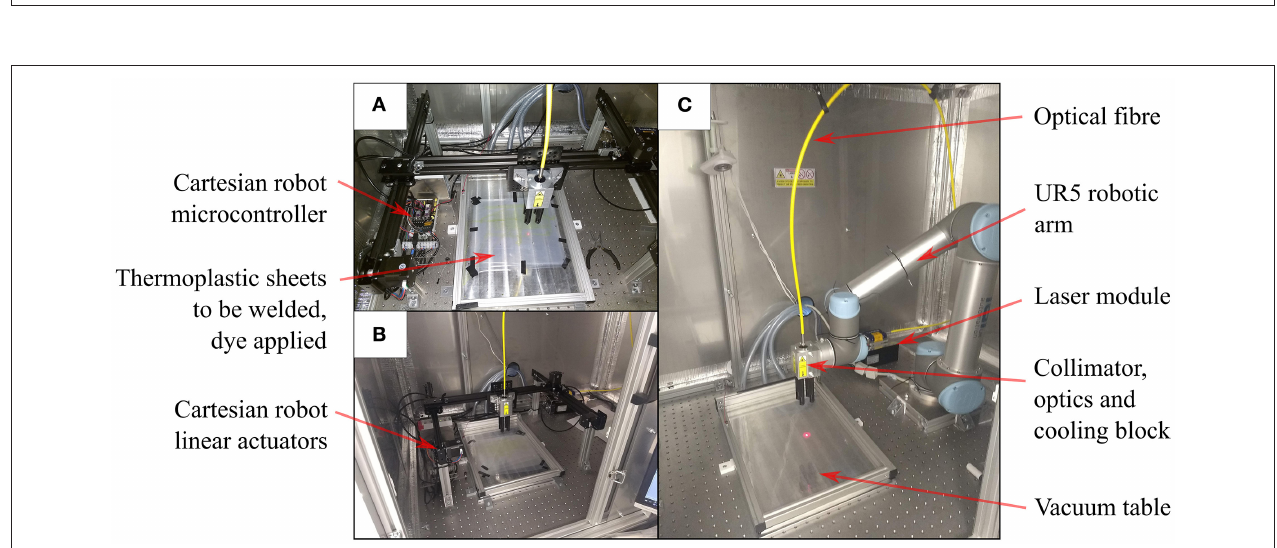
FIGURE 4 | Laser welding for planar designs (A) Cartesian robot with red pilot laser beam tracing a weld pattern at the interface between thermoplastic sheets (B) Cartesian robot within safety cabinet (C) Six DOF robot arm setup in the same cabinet for planar welds on the vacuum table.